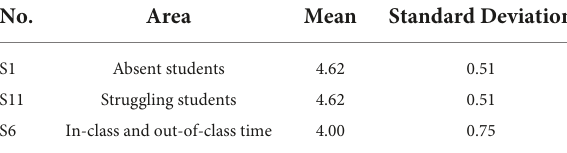
TABLE 5 Teachers’ perceptions of potential benefits for pupils in the FL.